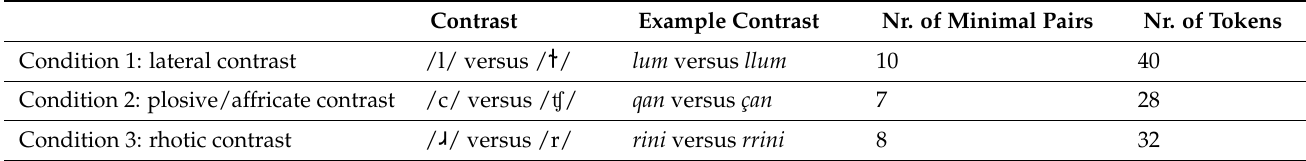
Table 3. Summary of tested contrasts.